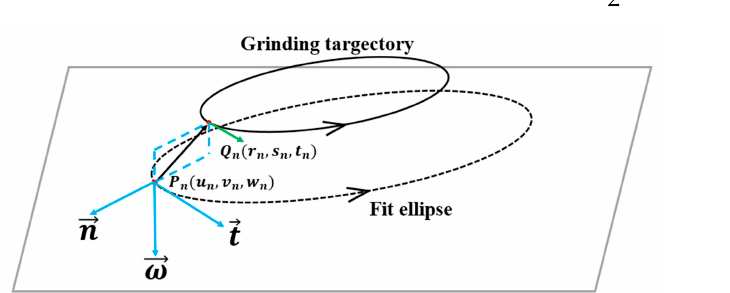
Figure 14. The relationship between grinding track and fitting ellipse.